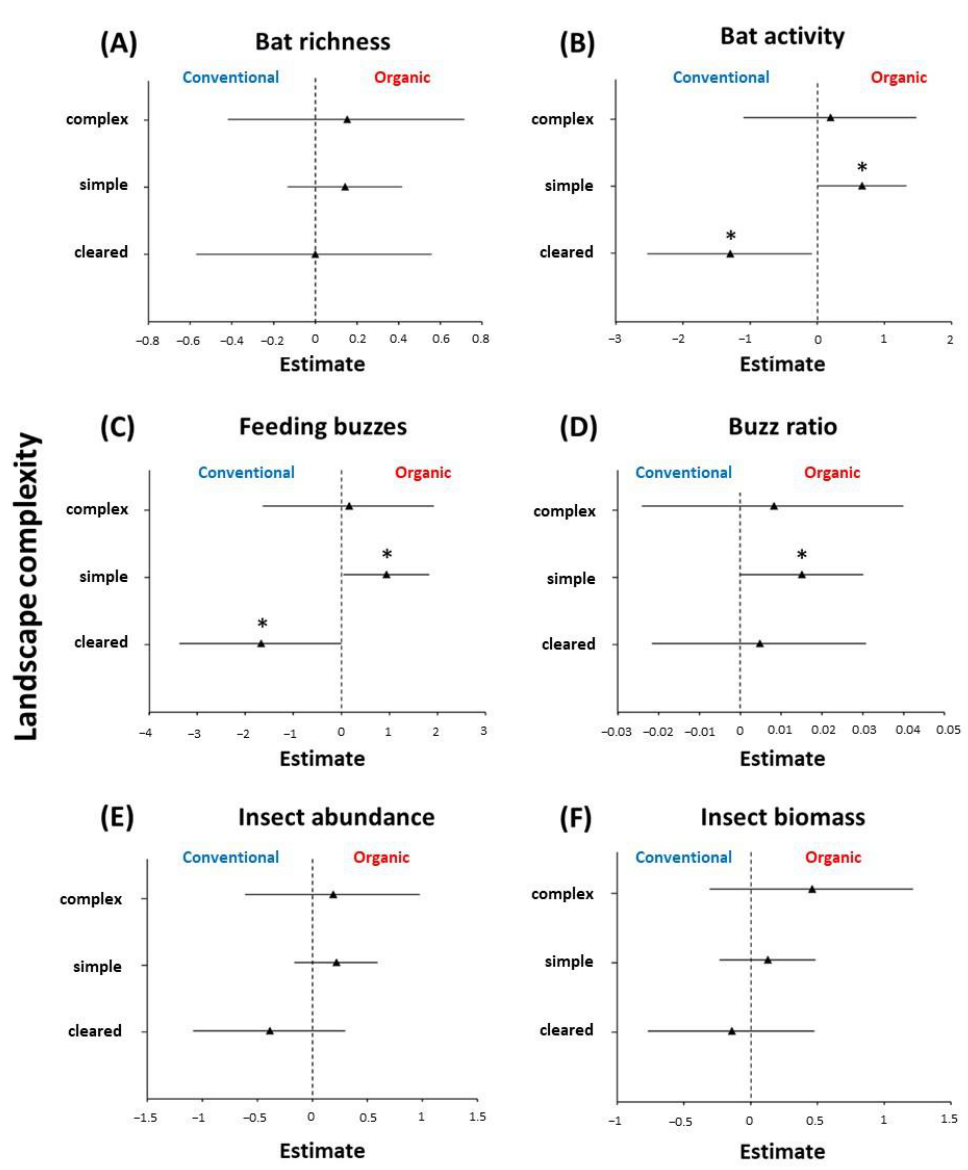
Figure 2. Effect sizes (mean ± 95% confidence interval are shown with black triangles and black solid lines, respectively) for bat richness ( A ), total bat activity ( B ), number of feeding buzzes ( C ), buzz ratio ( D ), insect abundance ( E ), and insect biomass ( F ) based on the difference in marginal means between organic rice fields and conventional rice fields across a gradient of landscape complexity (complex, simple, and cleared landscapes). Values on the right side of the dotted line suggest greater bat activity, number of feeding buzzes, species richness, or insect abundance in organic rice fields, while values on the left side of the dotted line suggest greater bat activity, number of feeding buzzes, species richness, or insect abundance in conventional rice fields. Asterisks denote effect sizes that are significantly different from zero ( p <